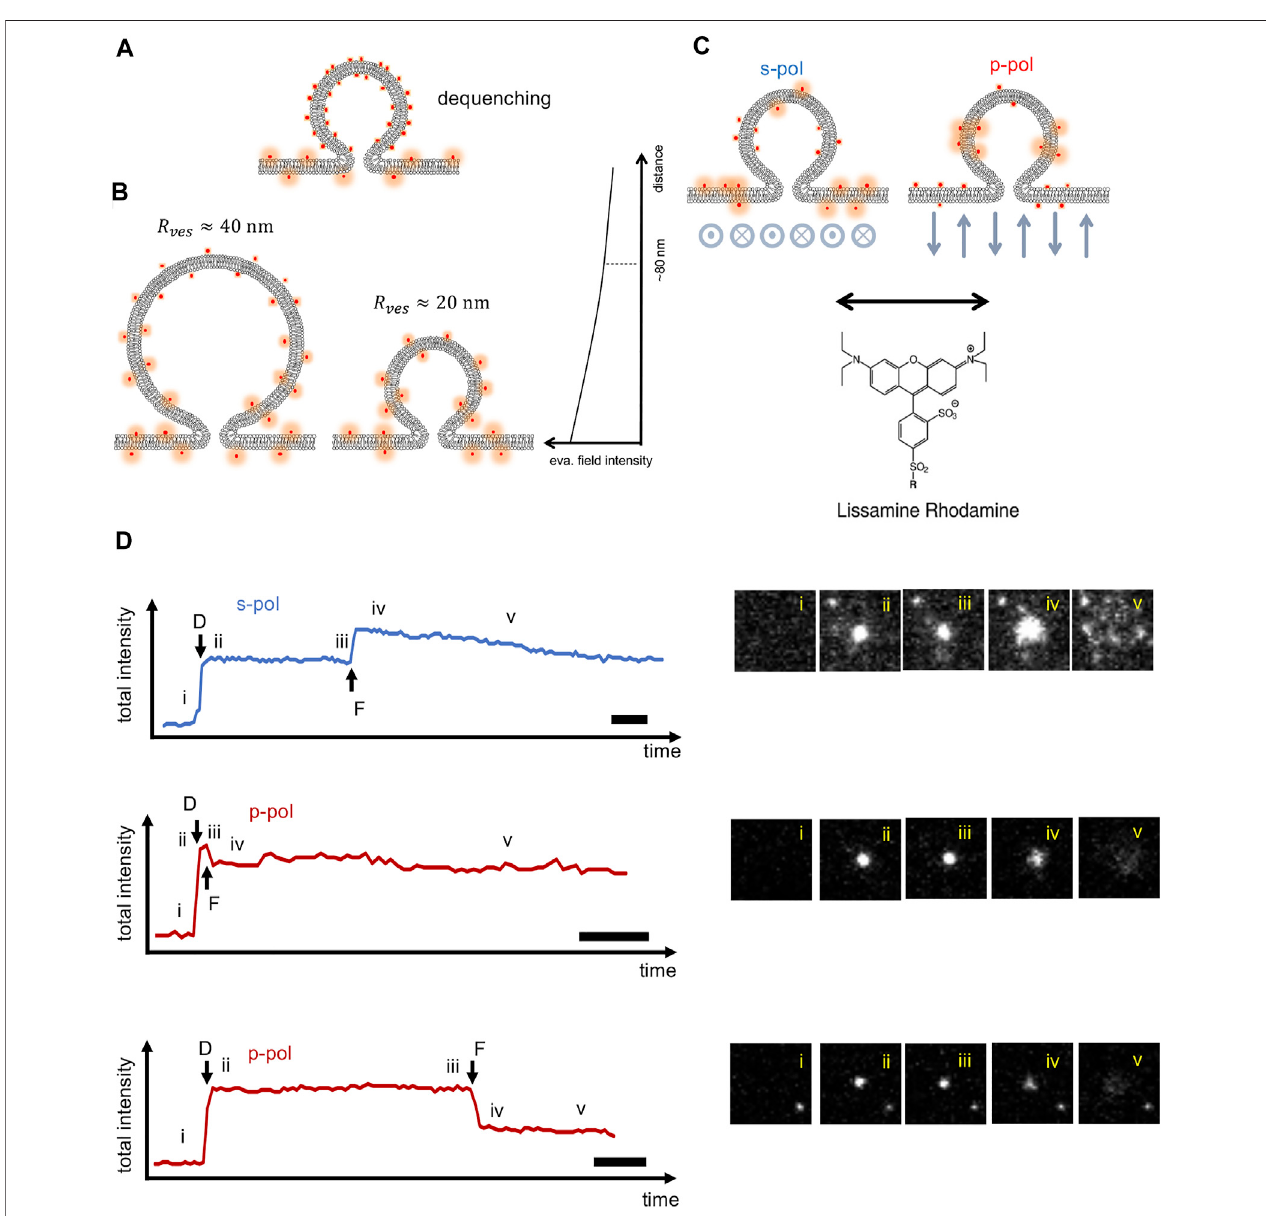
FIGURE 2 | Factors contributing to fl uorescence intensity changes observed during SUV-SBL fusion. (A) Dequenching. At suf fi ciently high density in the SUV membrane, lipid labels are self-quenched prior to fusion. Fusion with the SBL allows the fl uorophores to disperse and dequench. In our experiments, the fl uorophore density is kept to 1 mol %, minimizing dequenching ( ≲ 10% contribution). (B) Evanescent fi eld decay. Fluorophores closer to the glass-water interface experience a stronger excitation fi eld and are brighter, because the evanescent fi eld decays rapidly going away from the interface. Upon fusion, the fl uorophores are transferred to the SBL, closer to the interface, so the total intensity increases. The effect is stronger for larger SUVs, since on average the approach to the interface is larger. (C) Excitation polarization. A fl uorophore with an excitation dipole parallel to the membrane will be excited more ef fi ciently in the SBL than the SUV using s-pol excitation [electric fi eldperpendiculartotheplaneofincidence,indicatedbythesymbolsbelowtheSBLrepresentingarrowsgoingoutoftheplaneofthedrawingtowardtheviewer (dotinacircle)ortheotherdirection(crossinsidecircle)].Theoppositeistrueforp-polexcitation(thepolarizationdirectionisindicatedbytheup-downarrows).Notethat for all polarizations other than s-pol, the electrical evanescent fi eld is in fact elliptically polarized [see e.g., Axelrod et al. (1984)], which is not shown for simplicity. The structure of the lissamine rhodamine chromophore is shown (R is a phosphatidyl ethanolamine lipid). On average, the excitation dipole (double arrow) is expected to be nearly parallel to the membrane (Crane et al., 2005). (D) Examples of total fl uorescence intensity pro fi les of fusion events recorded with s- or p-pol excitation. LR-PE labeled vSUVs were fused with tSBLs while image stacks were recorded in TIRFM at 56 Hz. Every box is 8 μ m -by- 8 μ m (30 pixels by 30 pixels), large enough that diffusion of lipids outside the box is negligible during the analysis period. Using s-pol, fusion always results in an increase in total fl uorescence (top) , because both the evanescent fi eld (B) and polarization effects (C) contribute positively to the intensity change. Using p-pol excitation, the two effects compete, resulting in a minimal change (middle) ,decrease (bottom) ,orincrease(notshown).Scalebarsrepresent200 ms.Snapshotsoftheeventsareshowntotheright,usingthesamenumbering as in Figure 1 .